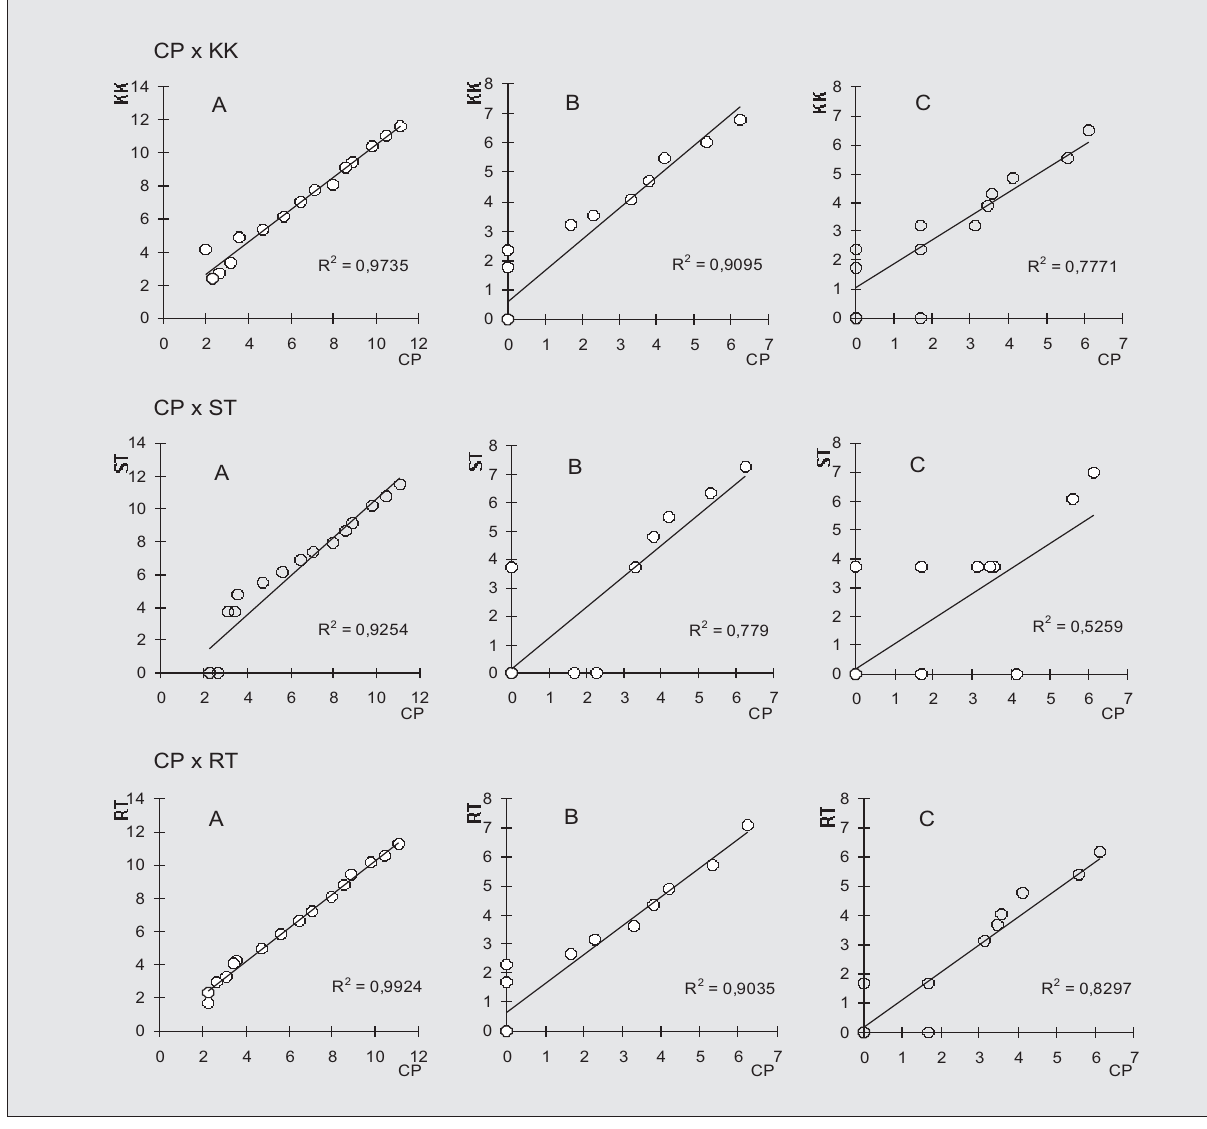
Figura 1 – Comparação entre os resultados do Coprotest ® quantitativo (CP) e dos métodos de Kato-Katz (KK), Stoll & Hausheer (ST) e Ritchie-Knight (RT) em amostras fecais com diferentes cargas de ovos das espécies: A – A. lumbricoides ; B – T. trichiura ; C – S. mansoni [Número de ovos por grama de fezes representado por ln Log Natural